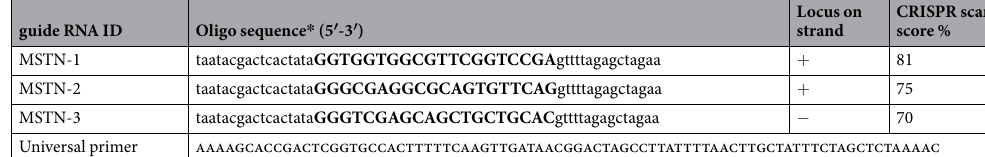
Table 1. The sequences of small guide RNAs and the universal (common) primer used to target exon I of the channel catfish myostatin (MSTN) gene. * The bold uppercase letters designate the target sequences (see Fig. 1).